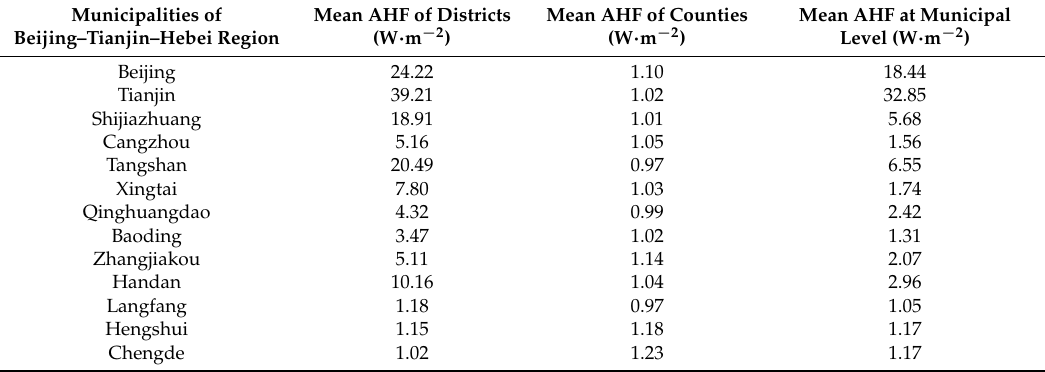
Table 1. The annual mean AHF of municipalities, districts and counties in the Beijing–Tianjin–Hebei region. Municipalities of Beijing–Tianjin–Hebei